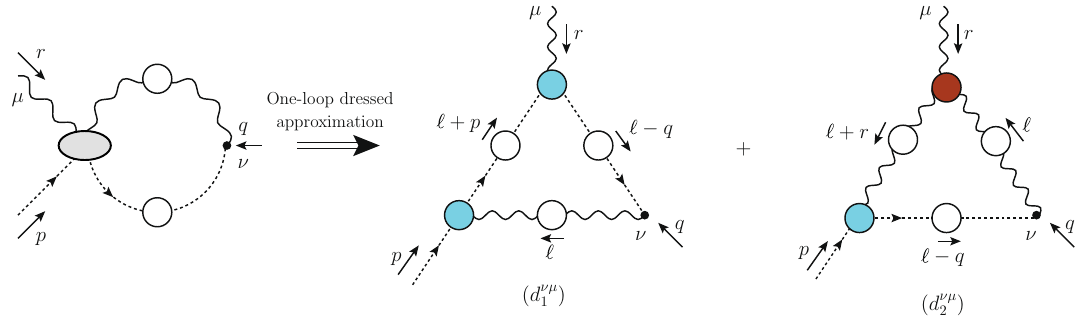
Fig. 7 One-loop dressed approximation of the SDE governing the ghost-gluon scattering kernel